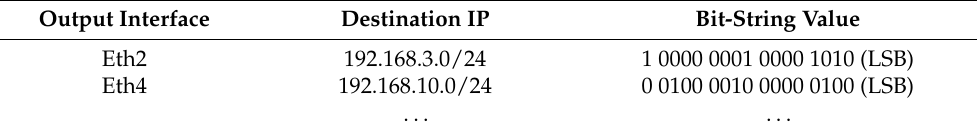
Table 10. Router R1—EB-REP Backup Table.